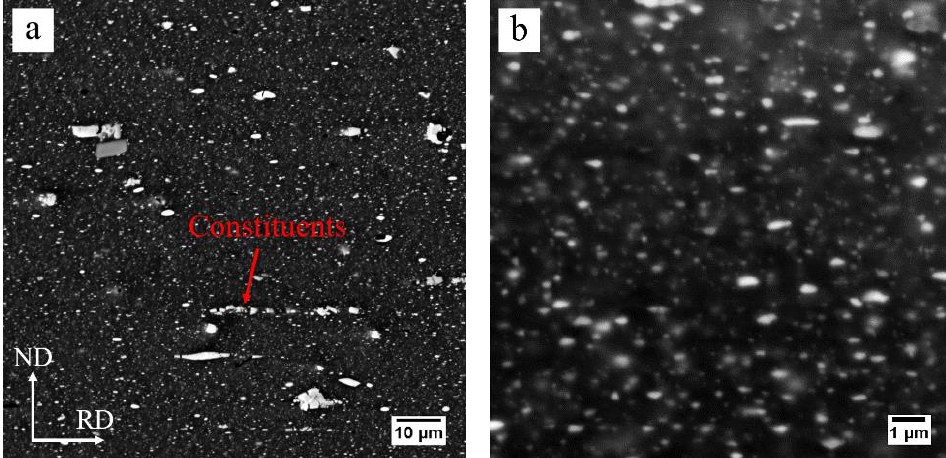
Figure 3. SEM images of the cold-rolled AA7075 sheet: ( a ) low magnification, ( b ) high